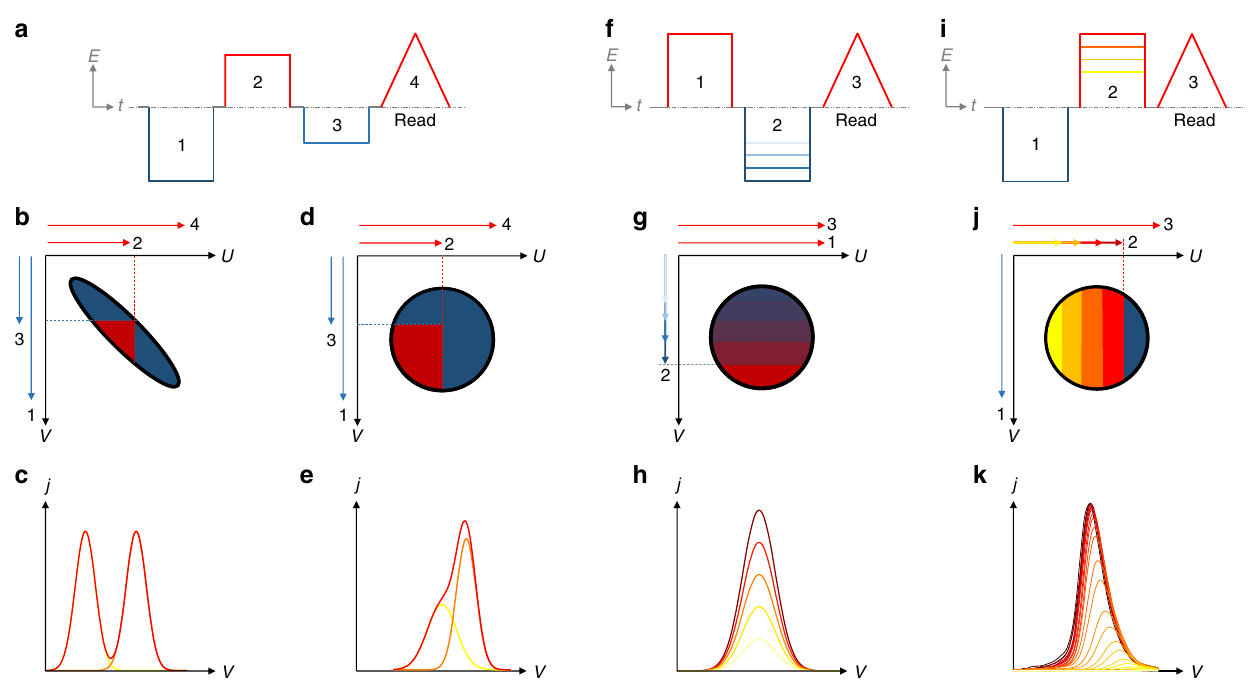
Fig. 8 Multi-bit memory writing and reading. a shows the pulse sequence (123) for setting the memory, with a subsequent sawtooth pulse (4) to read it out. The Preisach distributions after writing are shown in b , d , and the current during the readout pulse in c , e . Results are shown for the elongated PD, e.g., P(VDF-TrFE), on the left and the circular PD, e.g., BTA, on the right. Due to the round form of the PD in panels d , e , the two read-out peaks are indistinguishable. A different multi-bit data storage protocol is needed, see panels f – k . Two implementation modes are possible — down- fi lling ( f – h ) and up- fi lling ( i – k ) — and would give similar results in terms of switched polarization, see Supplementary Figure 8. The latter results in a shift of the peak position during the Fig. 8f – k. In this scheme, the PD is increasingly fi lled based on the amplitude of writing pulse 2. Integrated polarization results for this can be found in Supplementary Figure 8a.